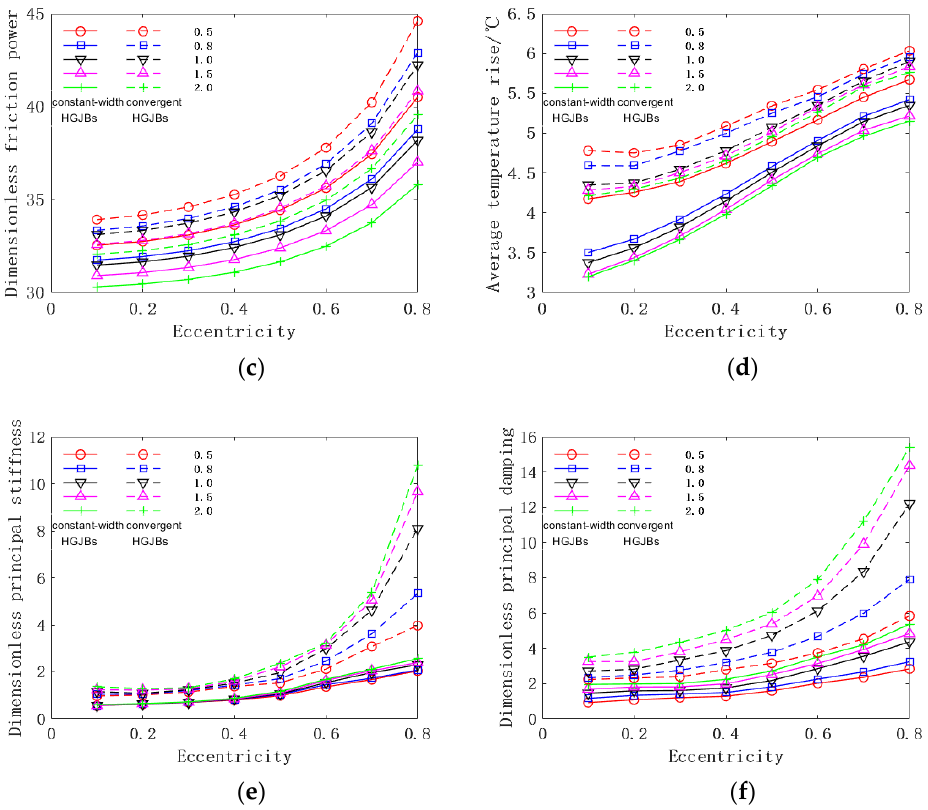
Figure 17. The influence of groove-ridge ratio on the performance of HGJBs: ( a ) Dimensionless load capacity ( b ) Side leakage ( c ) Dimensionless friction power ( d ) Average temperature rise ( e ) Dimensionless principal stiffness ( f ) Dimensionless principal damping.